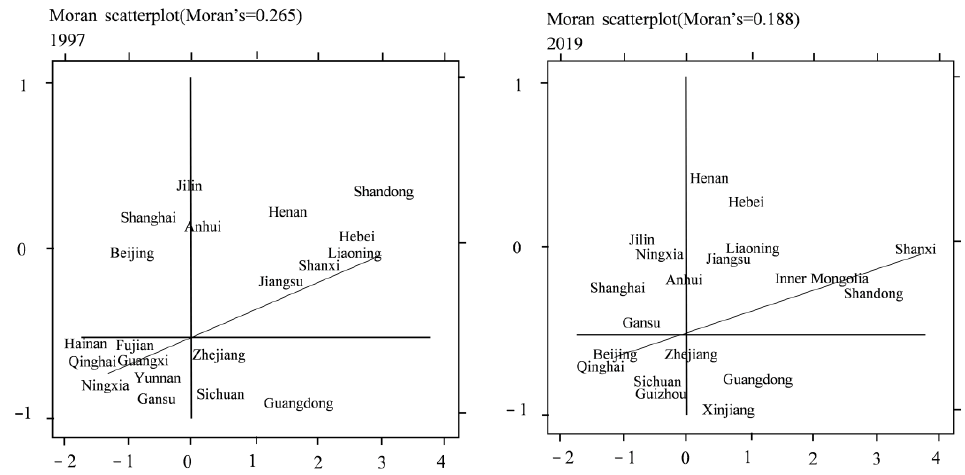
Figure 6. Local Moran charts of carbon emissions in 1997 and